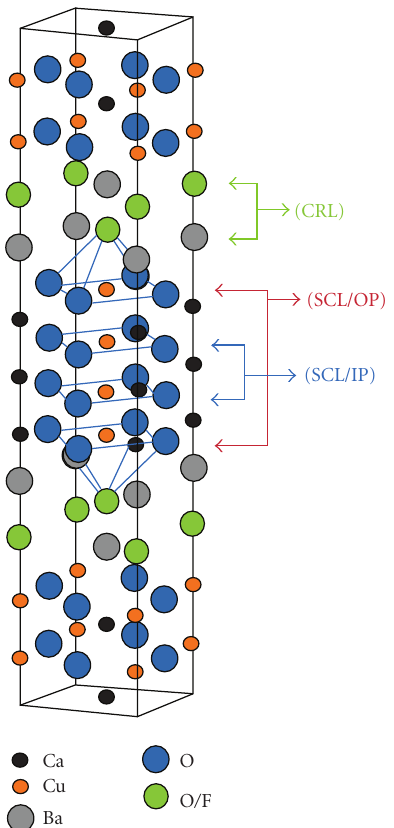
Figure 19: Crystal structure of Ba 2 Ca 3 Cu 4 O 8 (O δ F 1 − δ ) four CuO 2 layers in a unit cell with the outer having apical F atoms. CRL—charge reservoir layer; SCL/OP—superconducting layer/outer plane; SCL/IP—superconducting layer/inner plane. From